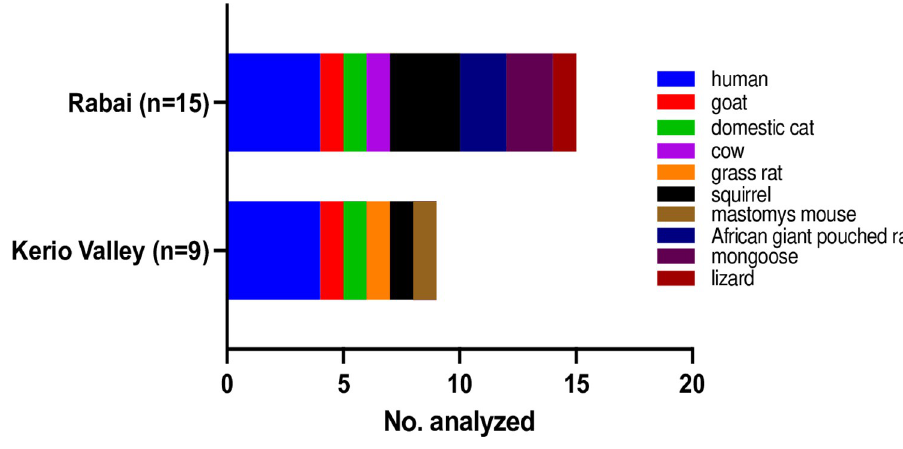
Fig 3. Aedes simpsoni host blood meals.